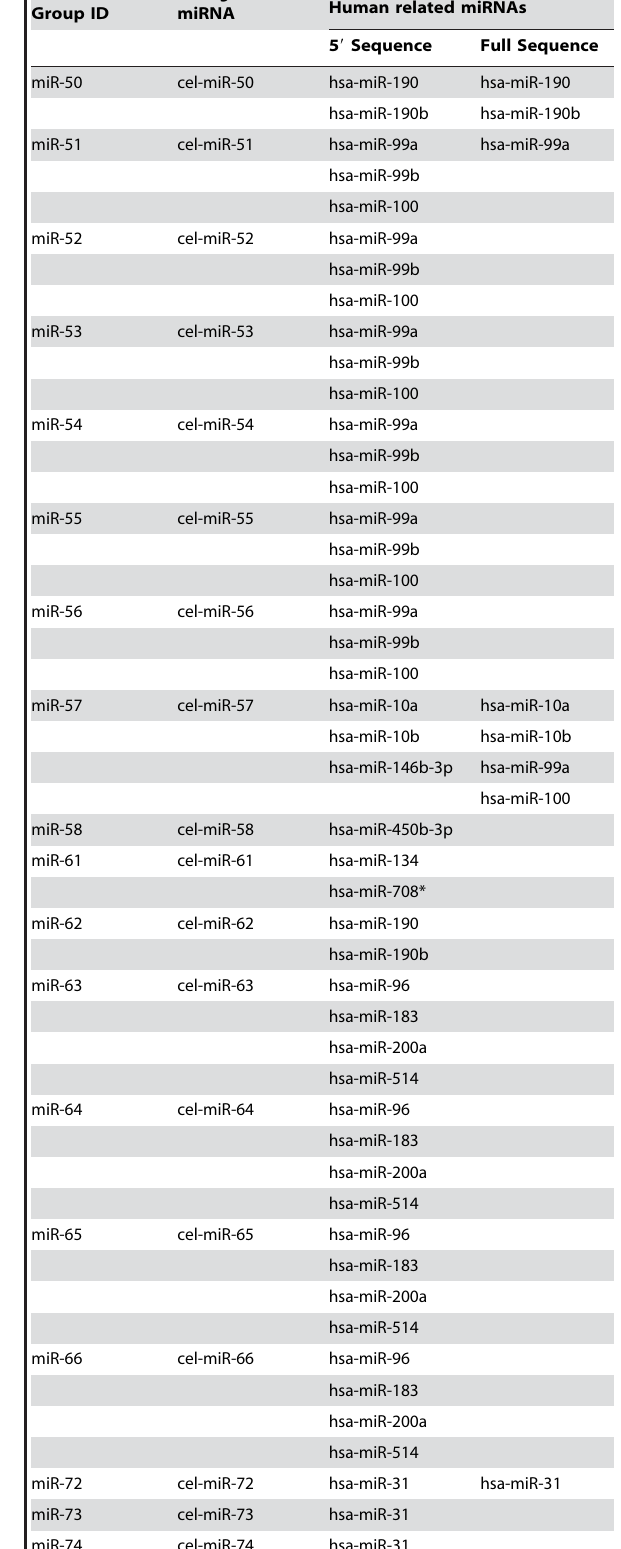
Table 4. Analysis of 5 9 and $ 70% full sequences identifies 76 C. elegans -human miRNA families including 76 worm miRNAs and 102 human miRNAs.